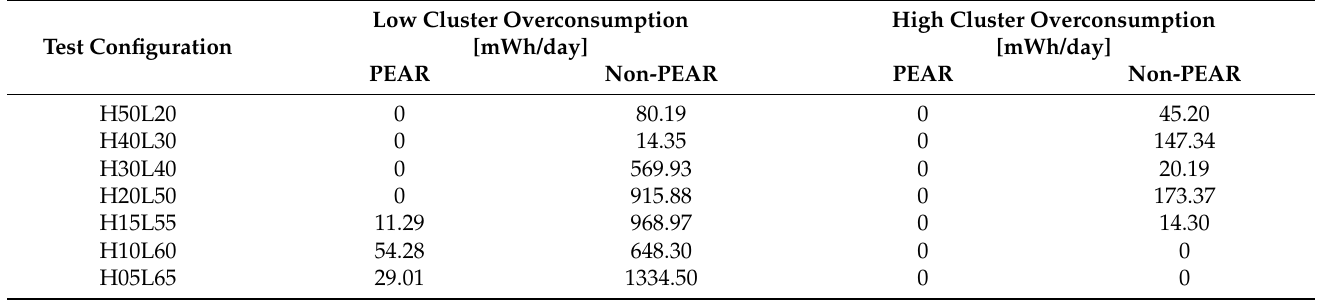
Table 6. The three profile cluster scenario parameters. Table 5. The PEAR and Non-PEAR cluster overconsumption per test